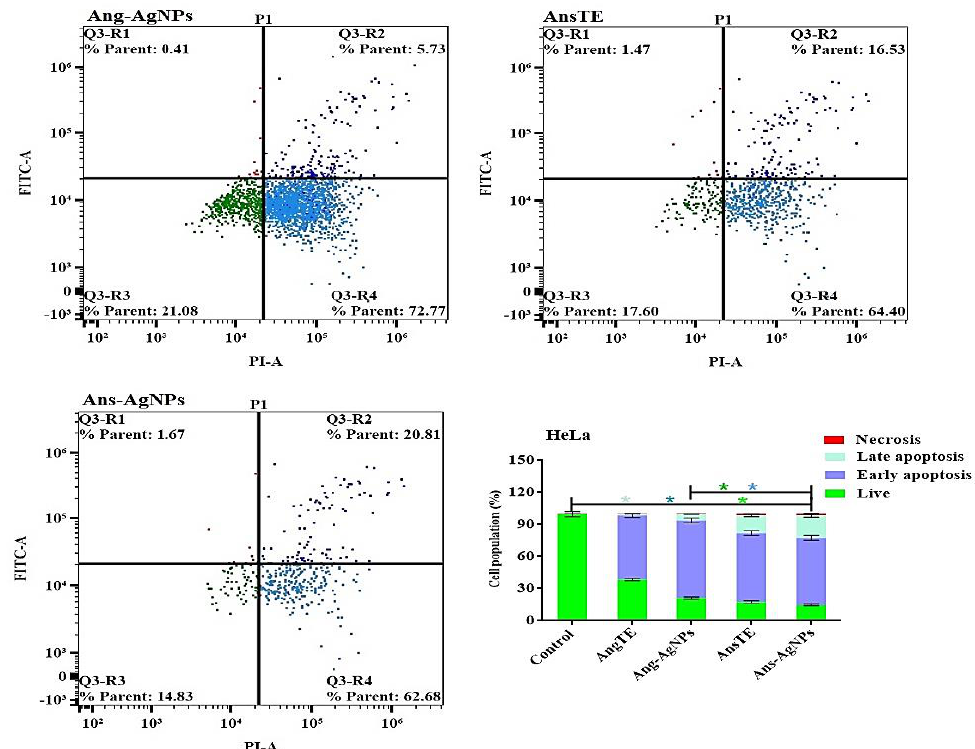
Figure 14. Apoptosis/necrosis assessment of the extracts, AngTE, AnsTE, and their nanoparticles, Ang-AgNPs, and Ans-AgNPs, respectively, against HeLa subjected to previous treatment for 48 h, and apoptosis/necrosis quantified using flow cytometry Data are presented as the mean ± SD; n = 3; One-way ANOVA was used to test for statistical difference (* p < 0.05).